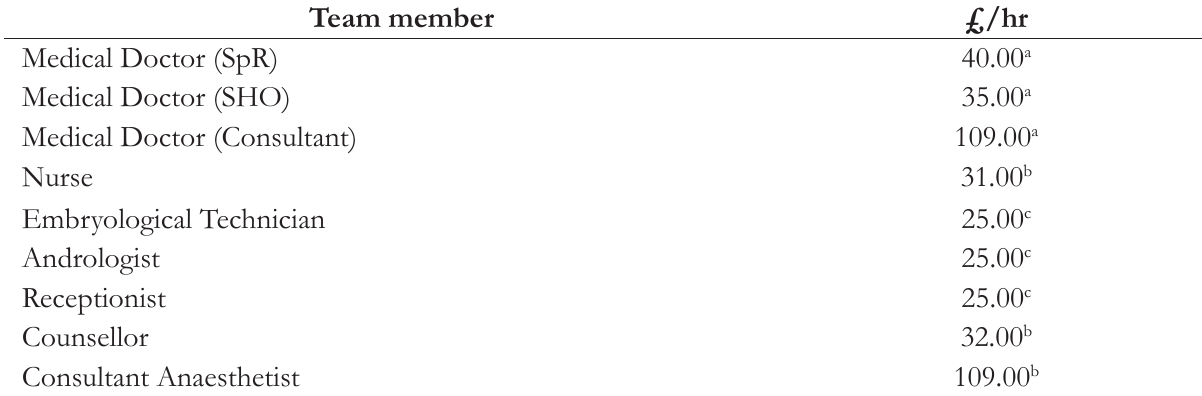
Table 1. Summary of Various Fertility Unit Personnel Costs (in GBP/hour) for Time-motion Comparison between First and Second IVF